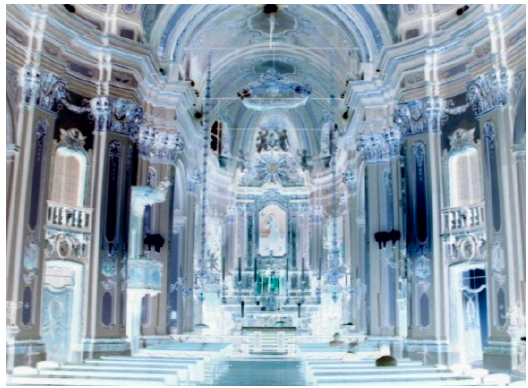
Figure 4. Photo edit. Author: Matteo